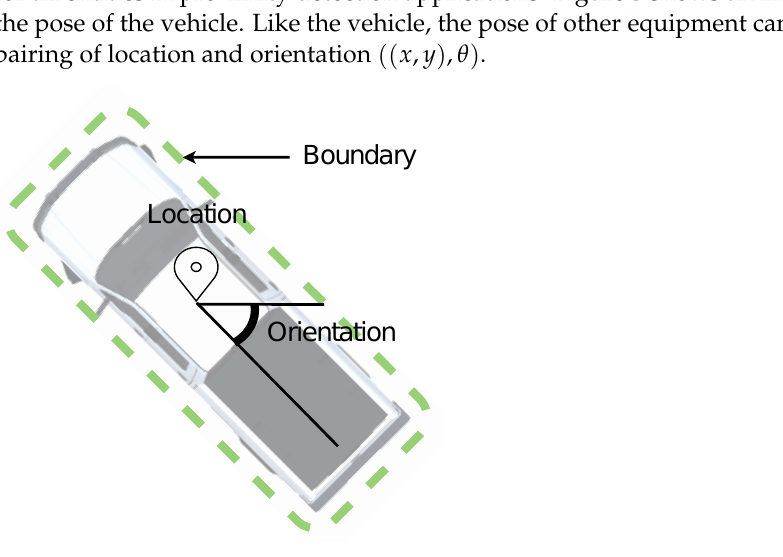
Figure 3. The defined boundary of vehicles in ViPER+.